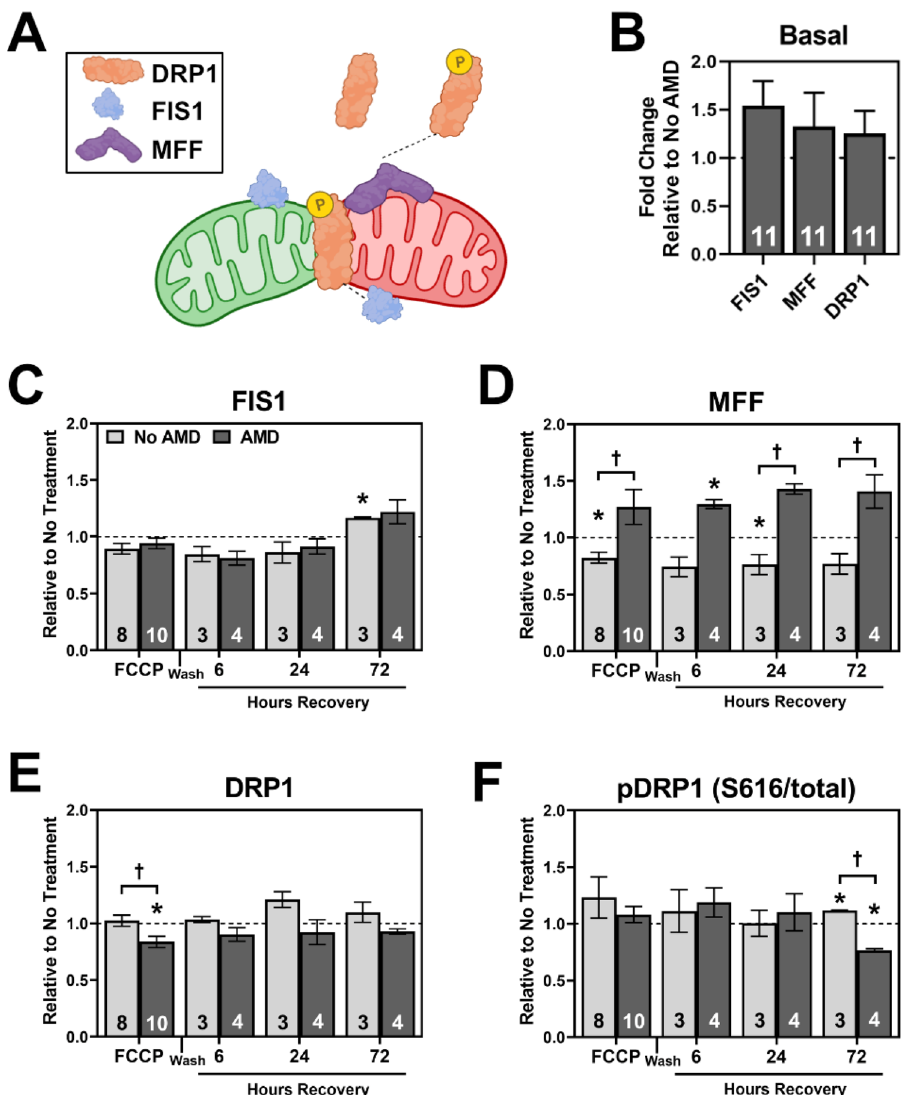
Figure 3. Response of Mitochondrial Fission Machinery to FCCP stress and recovery. ( A ) Summary of proteins involved in mitochondrial fission. Mitochondrial fission factor (MFF) and mitochondrial fission 1 protein (FIS1) activate under conditions of mitochondrial stress, recruiting dynamin-1-like protein (DRP1) to the site of fission. Once active by phosphorylation (P), pDRP1 divides the healthy (green) from the damaged (red) mitochondria. ( B ) Basal content of fission proteins in AMD RPE relative to No AMD RPE. ( C – F ) Quantification of fission proteins FIS1 ( C ), MFF ( D ), DRP1 ( E ), and pS616-DRP ( F ) after 4 h FCCP and recovery time points. All data shown is mean ± SEM. Number of samples for each experiment are provided in the bars. * denotes significance ( p < 0.05) from no treatment controls (dashed line). † denotes significance ( p < 0.05) between No AMD and AMD RPE. Panel A produced in